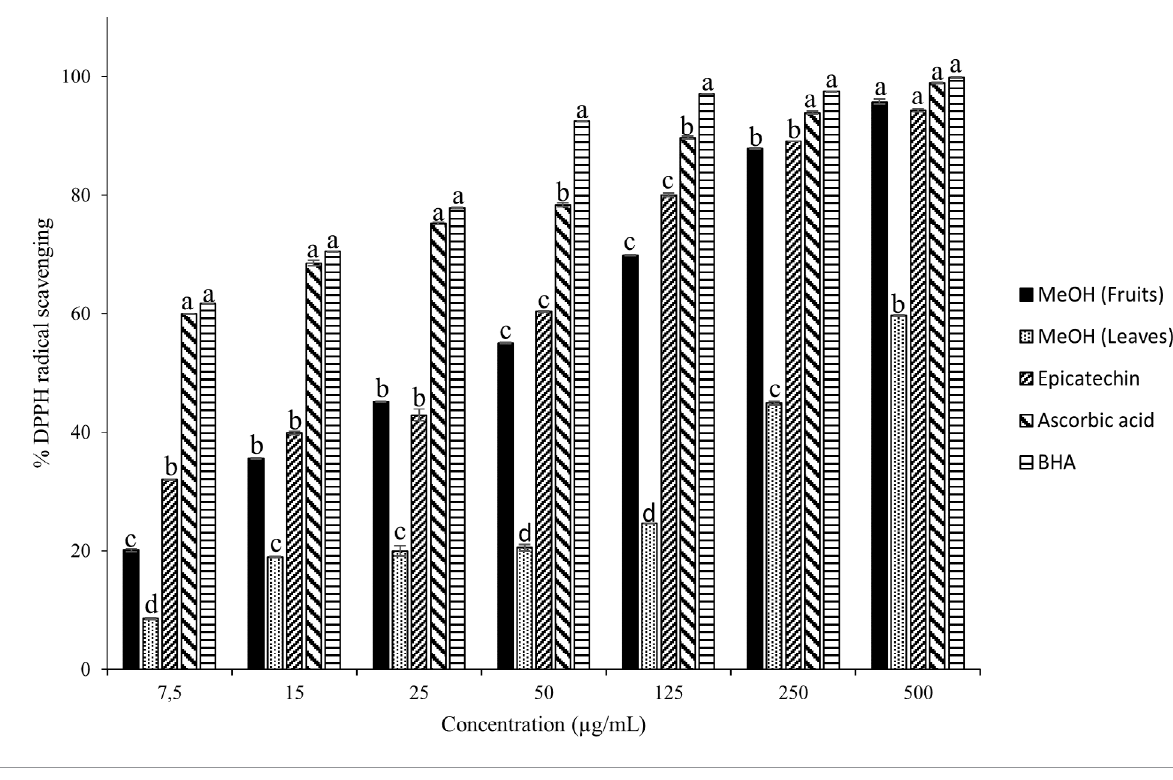
Figure 2: DPPH radical scavenging activity (%) of MeOH extracts of Ficus sur (fruits and leaves), epicatechin and positive controls (ascorbic acid and butylated hydroxyanisole (E320) (BHA)). Different letters over the bars indicate significantly different concentrations (Tukey’s HSD multiple range post-hoc test, p